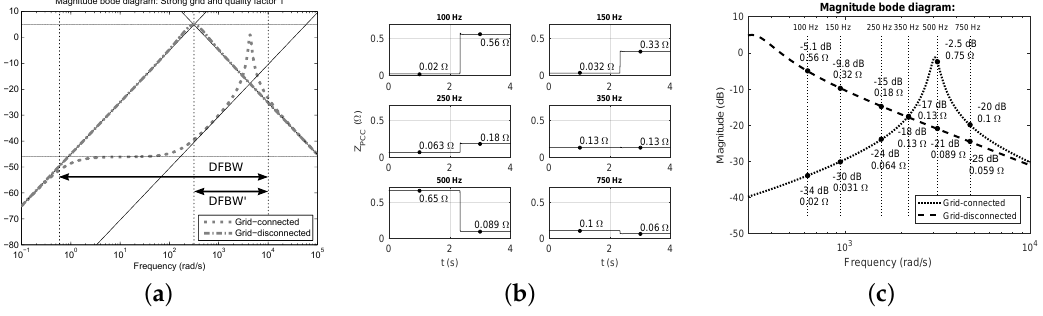
Figure 10. Frequency and impedance change analysis of the PCC impedance transfer function for a strong grid scenario and 30-kW/phase with q = 1 resonant load. ( a ) Bode diagram (magnitude). ( b ) Simulations of a PCC impedance shift after a grid disconnection. ( c ) PCC simulation test impedances on the Bode